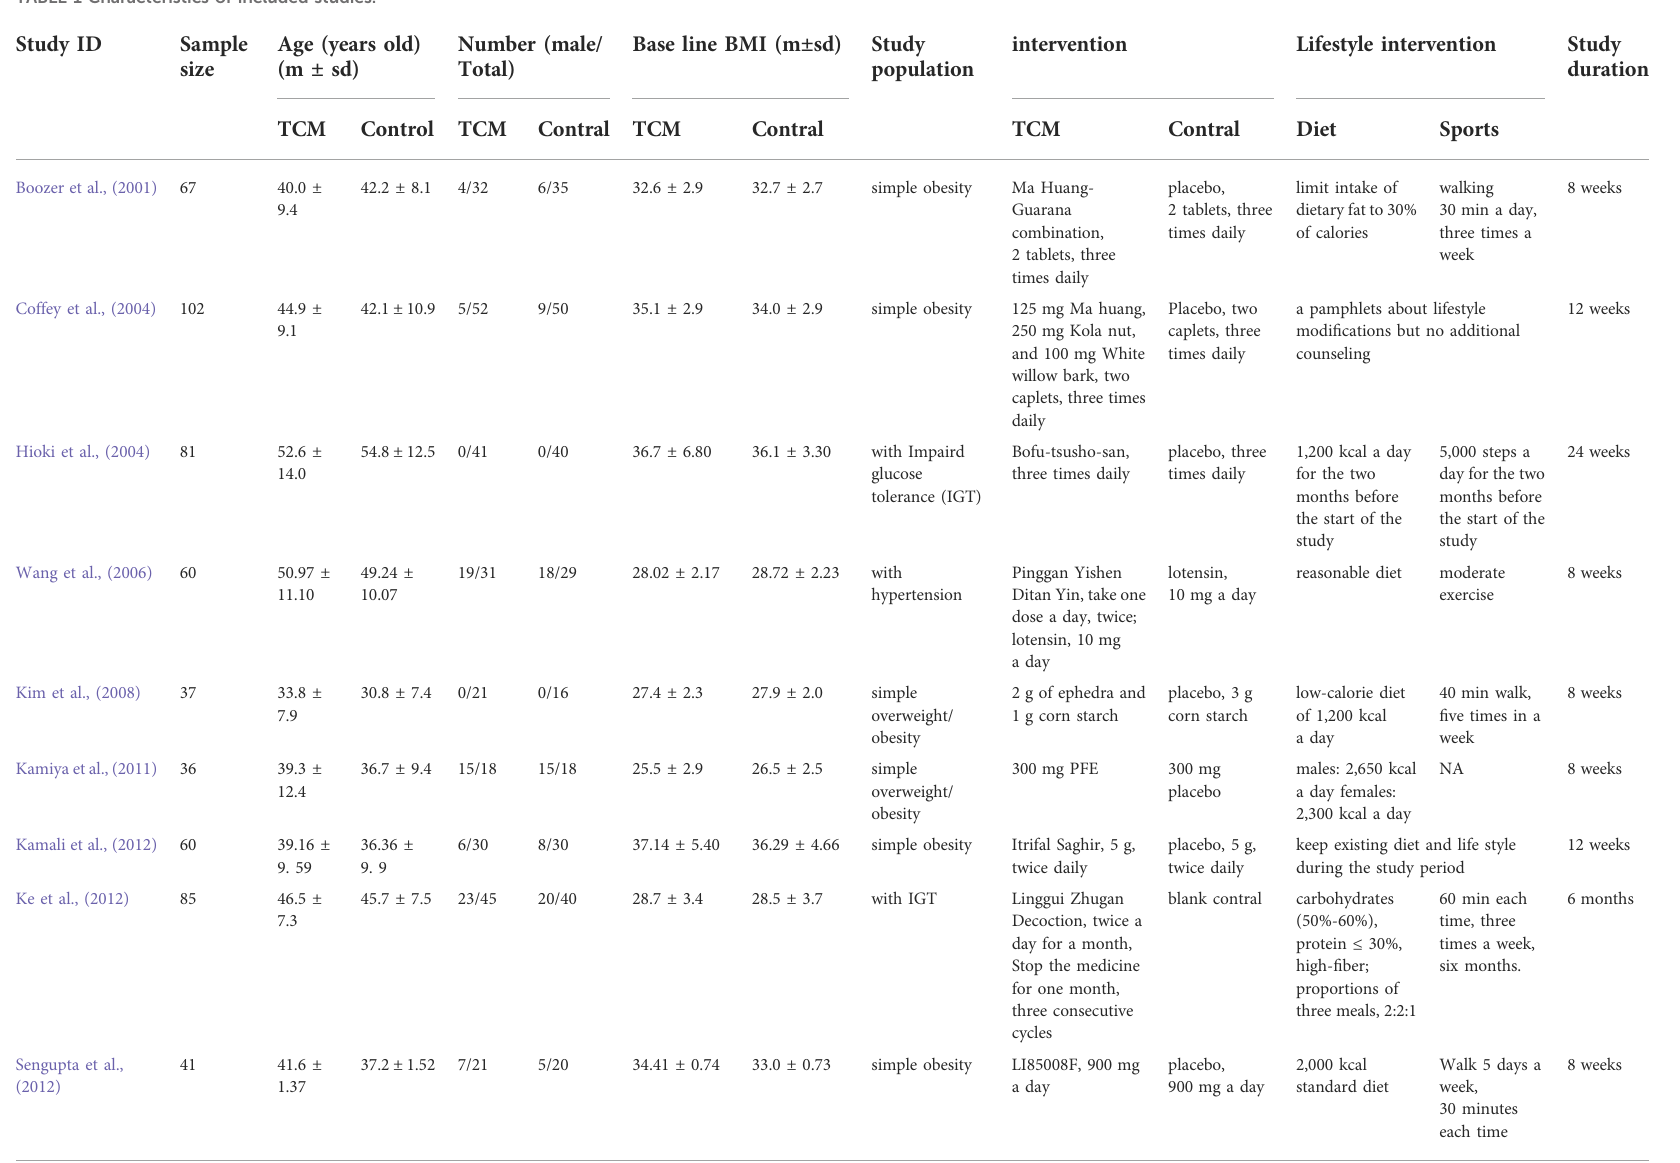
TABLE 1 Characteristics of included